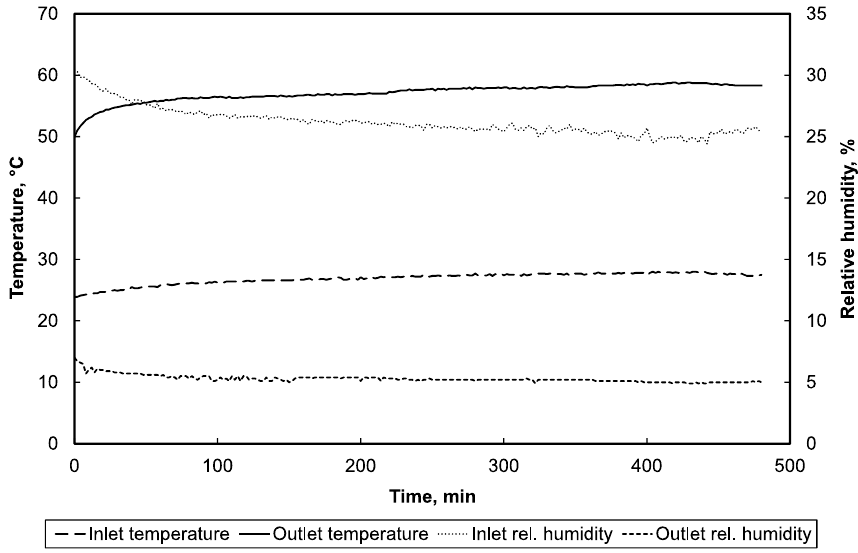
Figure 5. Typical dependence of air temperatures at the inlet and outlet of the solar thermal collector, and the corresponding air relative humidities, on drying time at the solar radiation intensity of 1100 W/m 2 . Table 5. Overall performance and efficiency of the solar thermal collector.